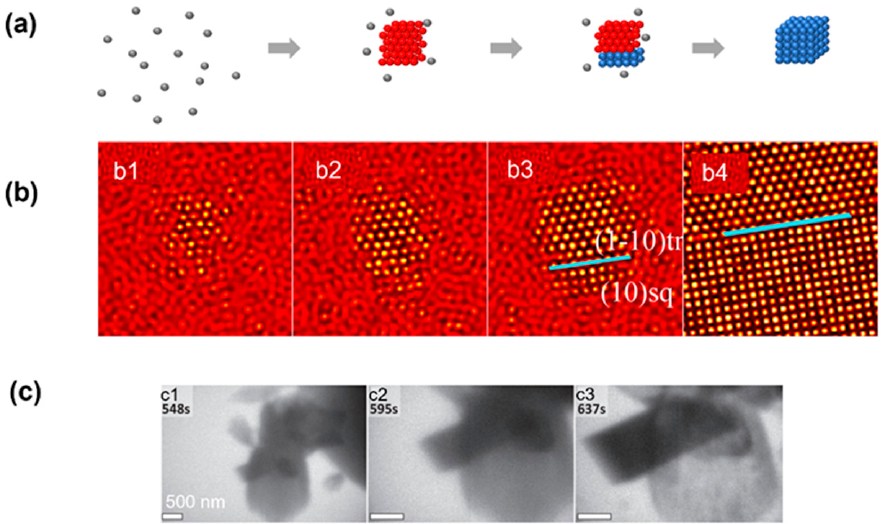
Figure 5. Simulation and experimental observations of the nonclassical crystallization pathway with the transition between multiple crystalline structures: ( a ) Schematics illustrating the nonclassical crystallization pathway, highlighting the formation of an intermediate crystalline lattice before achieving the final product. ( b ) Simulation snapshots illustrating the formation of an amorphous intermediate triangular lattice first and the transition into a square lattice through heterogeneous nucleation. From ( b1 ) to ( b4 ), the temporal evolution of a single nucleus is shown, and the blue line indicates the boundary between two phases. Reproduced with permission from Ref. [35]. Copyright 2016 American Chemical Society. ( c ) Liquid-phase TEM observations of the heterogeneous nuclea- tion of calcite crystal occurring on aragonite, followed by calcite growth and concomitant dissolu- tion of the aragonitic bundle. From c1 to c3 , the temporal evolution of the nucleation of calcite crystal on the surface of aragonite is captured by liquid-phase TEM. Reproduced with permission from Ref. Copyright 2014 American Association for the Advancement of